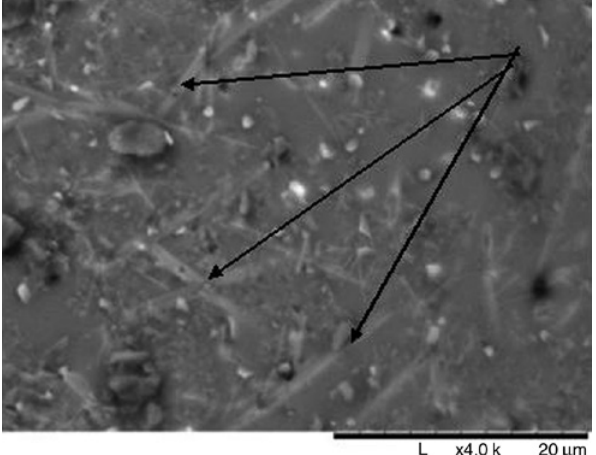
Figure 3: SEM micrograph of electrically conductive frame formed by carbon nanoparticles (shown by arrow) in the matrix of UHMWPE for composite containing 1.5 wt% of filler.